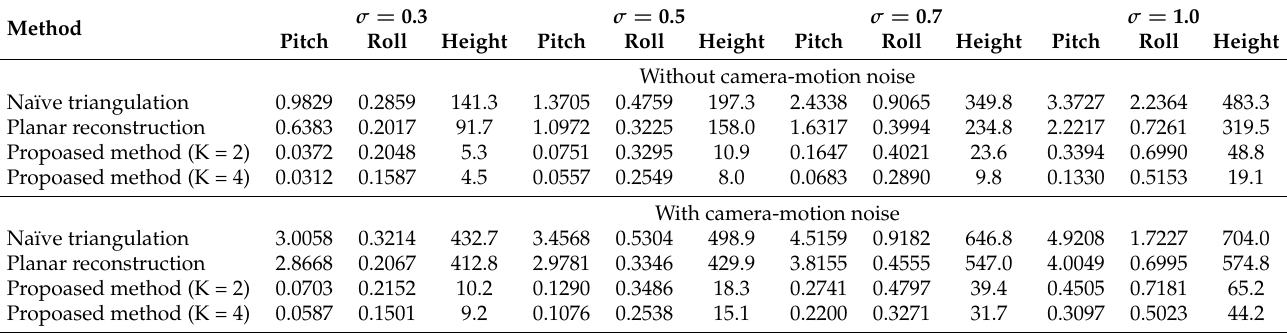
Table 2. Calibration accuracy in simulation environment with respect to various amounts of pixel noise. σ = 0.3 σ = 0.5 σ = 0.7 σ = 1.0 Method